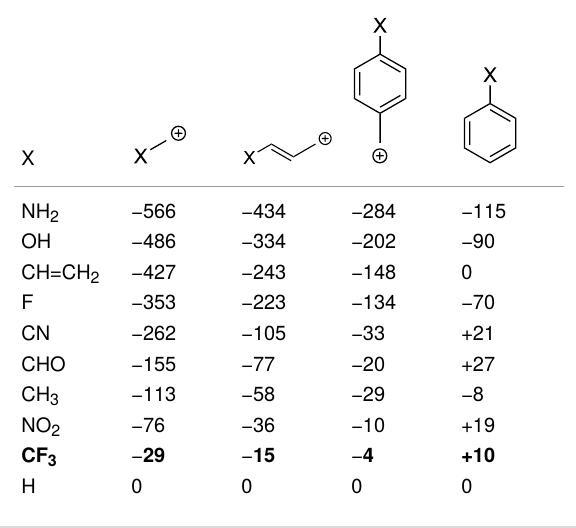
Table 2: π -Electron-transfer parameters from STO-3G calculations with optimized C–X bond length (established as ∑ q π , without unit) for substituents X in alkyl, allylic, and benzylic carbenium ions. Parame- ters for neutral phenyl derivatives are given for comparison. Negative values indicate π -electron donation by the substituent